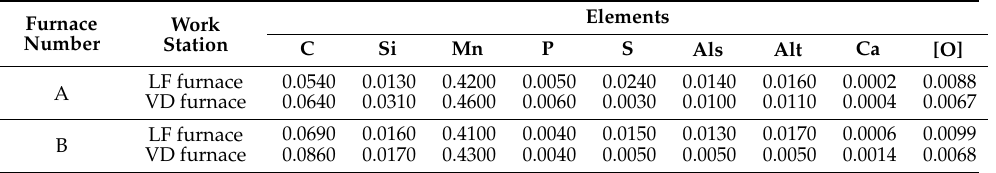
Table 3. The chemical composition of steel samples in different working stations Table 2. The operation parameters of calcium treatment in industrial production.